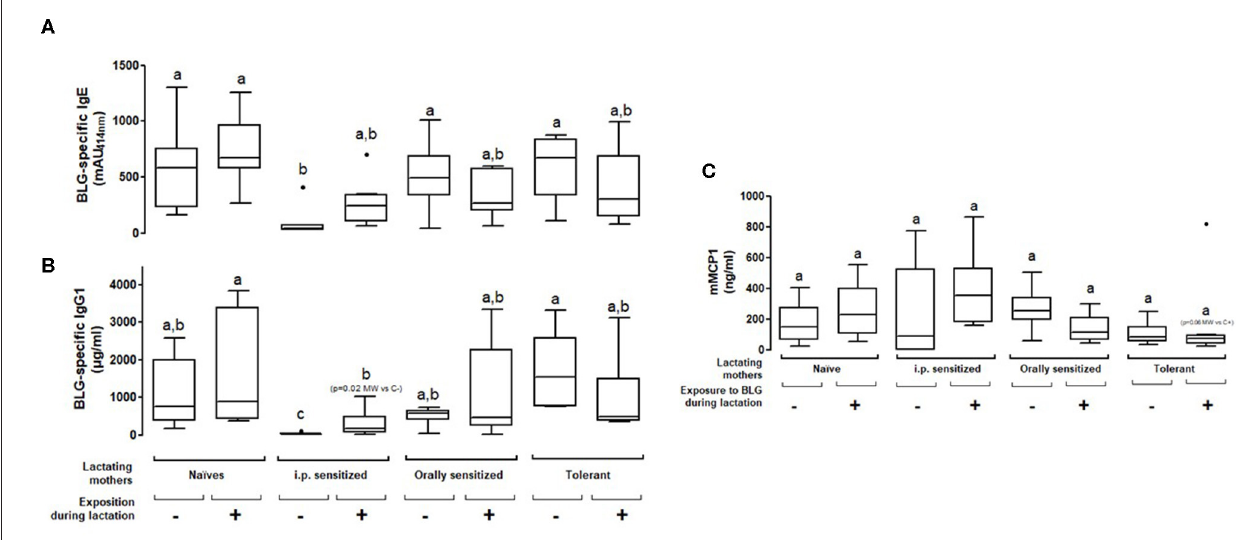
FIGURE 4 | Plasma BLG-Specific IgE (A) , IgG1 (B), and mMCP1 (C) induced after two i.p. sensitizations and then an oral food challenge with BLG in pups fostered by naïve or prenatally sensitized or tolerized mothers, further orally exposed ( + ) or not (–) to BLG during lactation. Tukey box and whiskers from 7 to 8 mice/groups are shown. Statistical analysis evidenced differences between groups ( p = 0.002 for IgE and p = 0.038 for mMCP1, non-parametric Kruskall Wallis test). Pairwise multiple comparisons were then conducted using Conover-Iman testing, including Bonferroni correction for multiple testing. Groups indicated with different letters are different from each other’s ( p < 0.05). p -values obtained using additional testing against controls by Mann Whitney test are also indicated (MW).